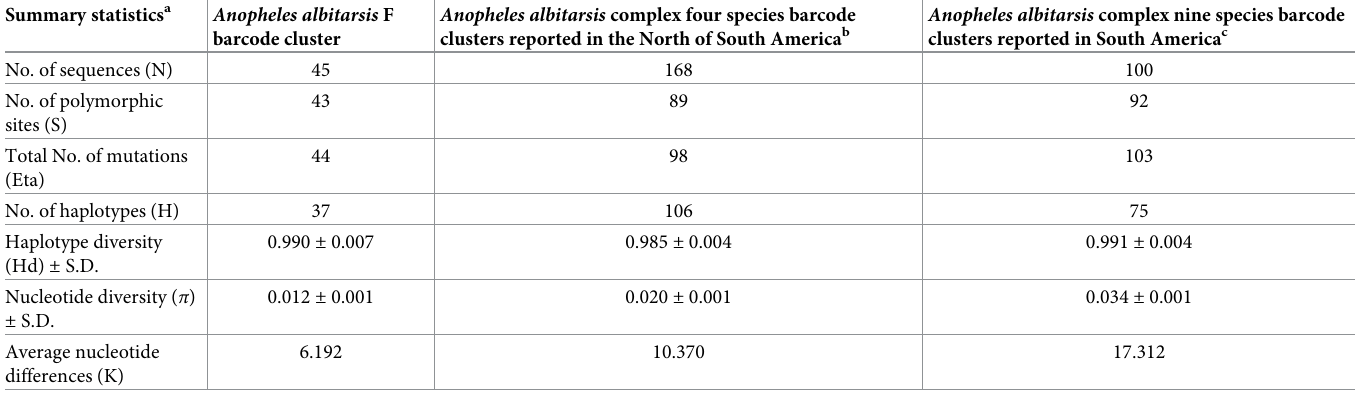
Table 1. Summary of MT-CO1 sequences datasets